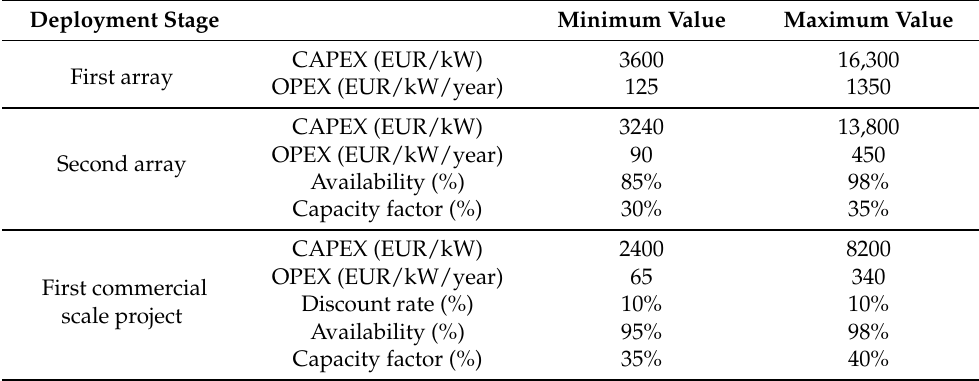
Table 2. An example of estimated CAPEX and OPEX values for different deployment stages [4]. The maximum value is either that from the responses of consulted developers or from any of the reference studies analysed. This is particularly true for the OPEX, where developers were presenting costs significantly more optimistic than past studies have suggested. An exchange rate of USD 1.11 to EUR has been applied. Data adapted from